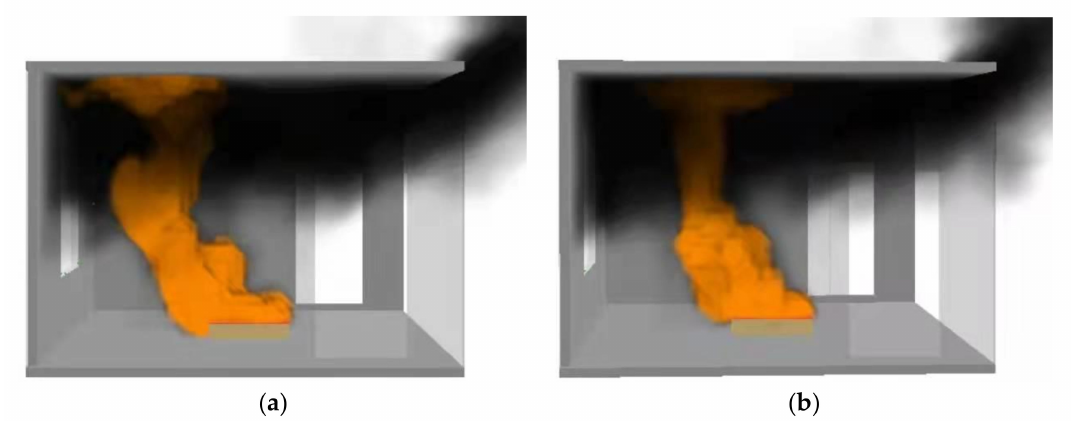
Figure 20. Smoke distribution under the action of a window sprinkler: ( a ) 50 s, ( b ) 150 s. Figure 23 is the convection heat flux curve at different positions on the window